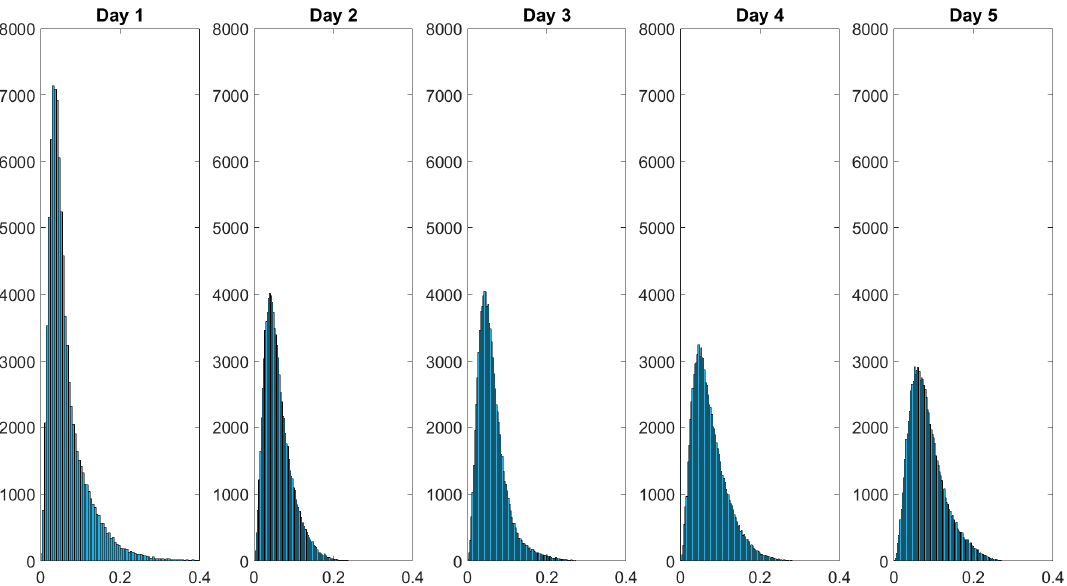
Figure 11. Histograms of the diattenuation 𝐷 data monitoring the wound healing of a finger cut. The intensity distribution of 𝐷 flattens over the healing time. The values in the dataset are displayed on the x ‐ axis and the frequency of each value is displayed on the y ‐ axis.